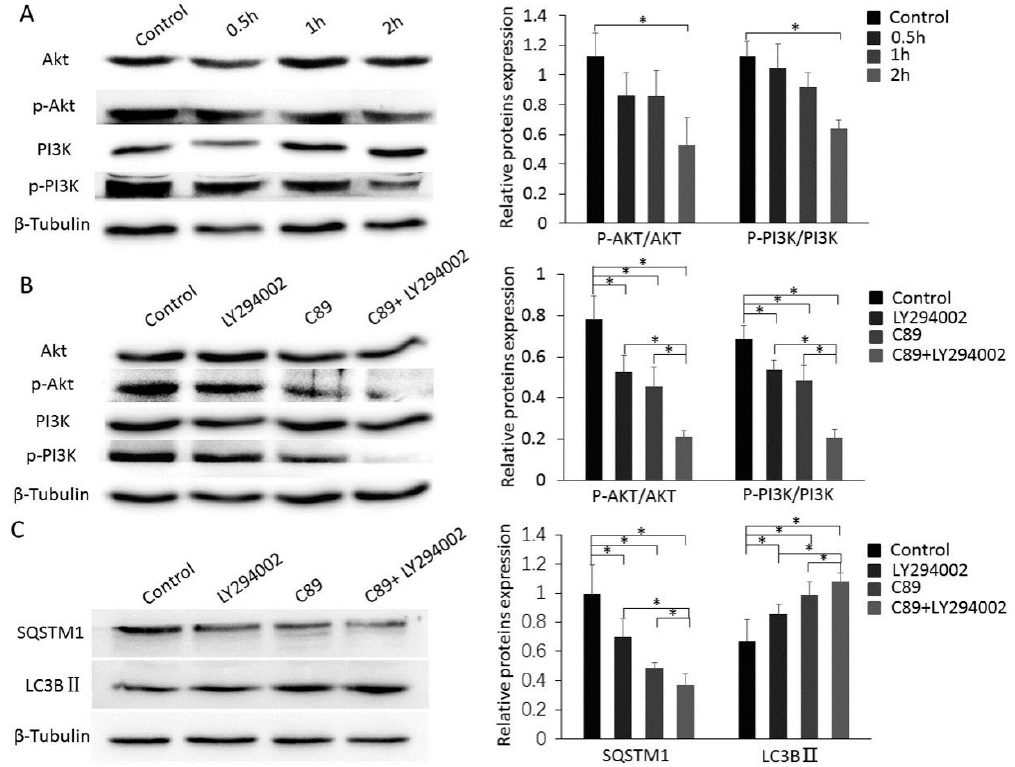
Figure 4. Cooperative functions of C89 and LY294002 in inducing autophagy via suppressing the PI3K-Akt pathway. ( A ) Western blot of Akt, p-Akt, PI3K, and p-PI3K in FGSCs treated with C89. C89 significantly reduced the expression levels of p-Akt and p-PI3K at 2 h ( p < 0.05). ( B ) C89 reduced the expression levels of p-Akt and p-PI3K. Western blot of Akt, p-Akt, PI3K and p-PI3K in FGSCs treated with LY294002, C89, C89 + LY294002 or controls for 2 h. The expression levels of p-Akt and p-PI3K were significantly lower in LY294002, C89, and C89 + LY294002 groups compared with